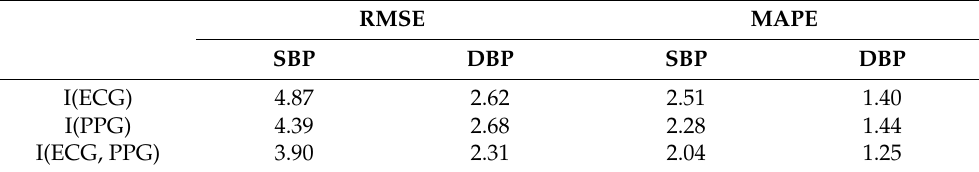
Table 2. Experimental results obtained by using different combinations of input signals.